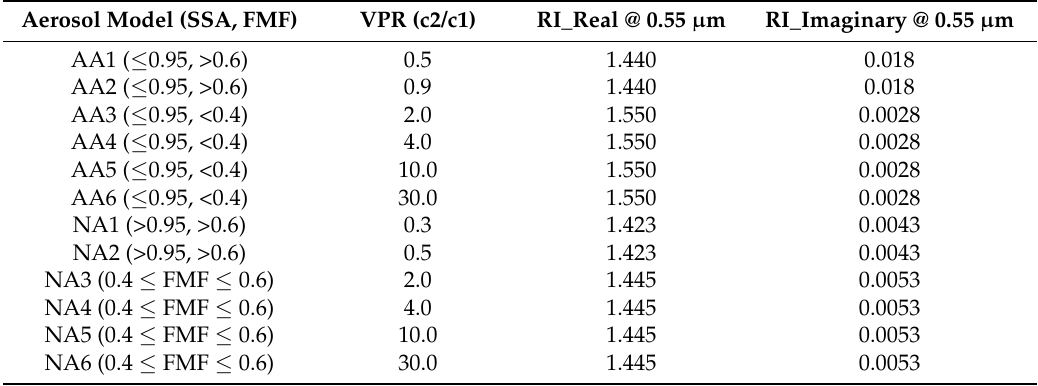
Table 2. Aerosol models were classified using FMF, volume peak ratio, and refractive index at 0.55 µ m of the AERONET inversion data for the lookup table of the TANSO-CAI aerosol